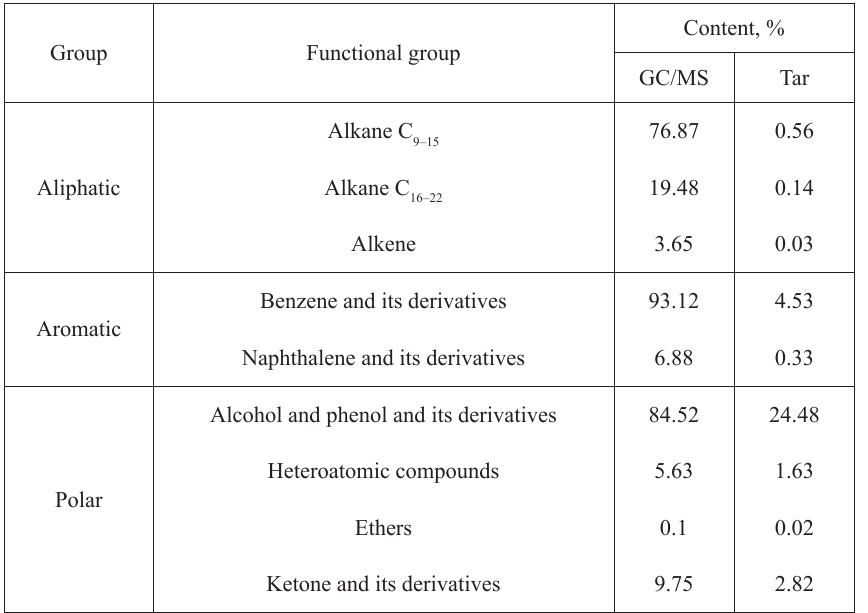
Table 8. The results of GC/MS analysis of the middle distillation fraction (250–320 °C) of pyrolysis